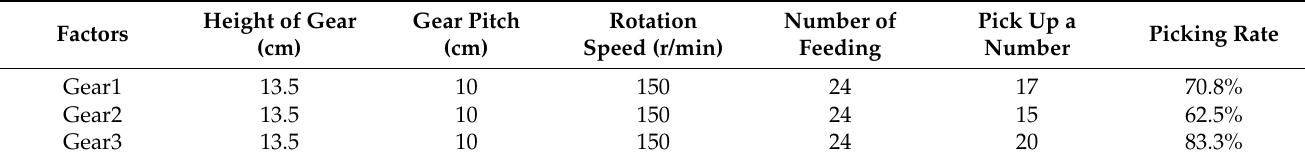
Table 5. Experimental design on single-factor effect test of tooth